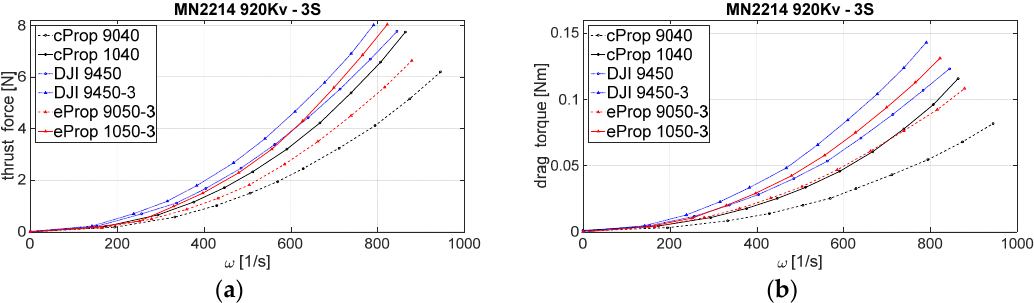
Figure 17. Aerodynamic effects with respect to rotor angular velocity, MN 2214 BLDC motor: ( a ) thrust force; ( b ) drag torque.